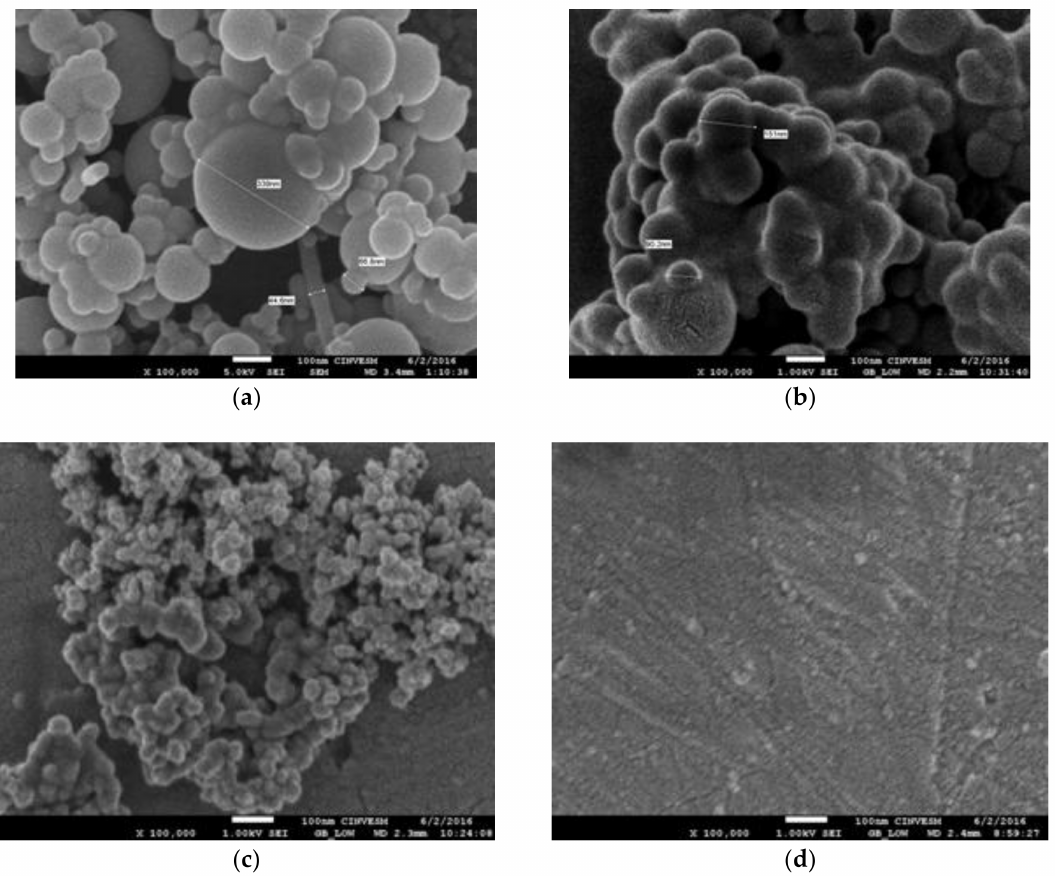
Figure 4. SEM micrographs of composites at 100,000 × . ( a ) CP2 composite; ( b ) CP4 composite; ( c ) CP20 composite and ( d ) CP22